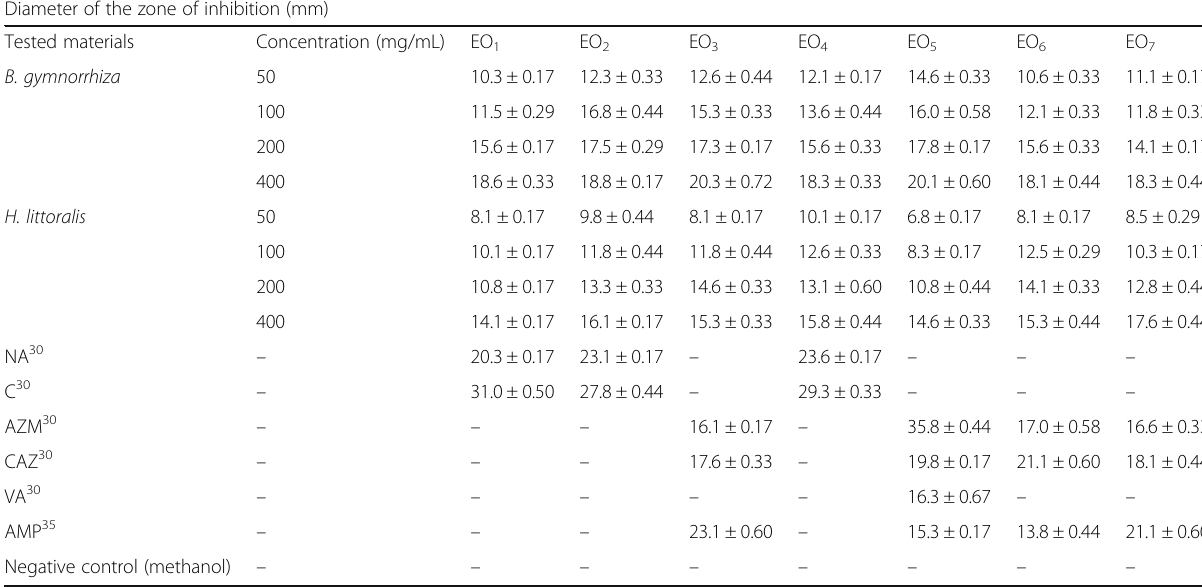
Table 3 In vitro activity of methanol extracts of B. gymnorrhiza and H. littoralis leaves against some opportunistic pathogens Diameter of the zone of inhibition (mm) Tested materials